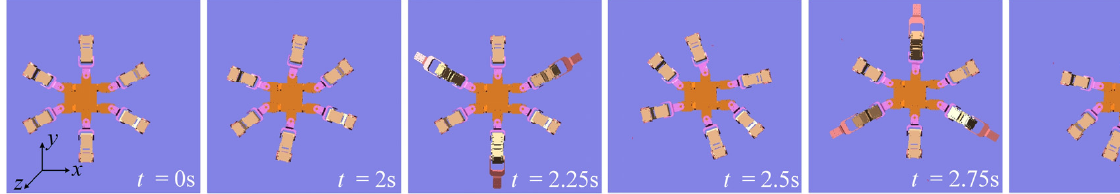
Figure 9. The simulation screenshots of the tripod gait.